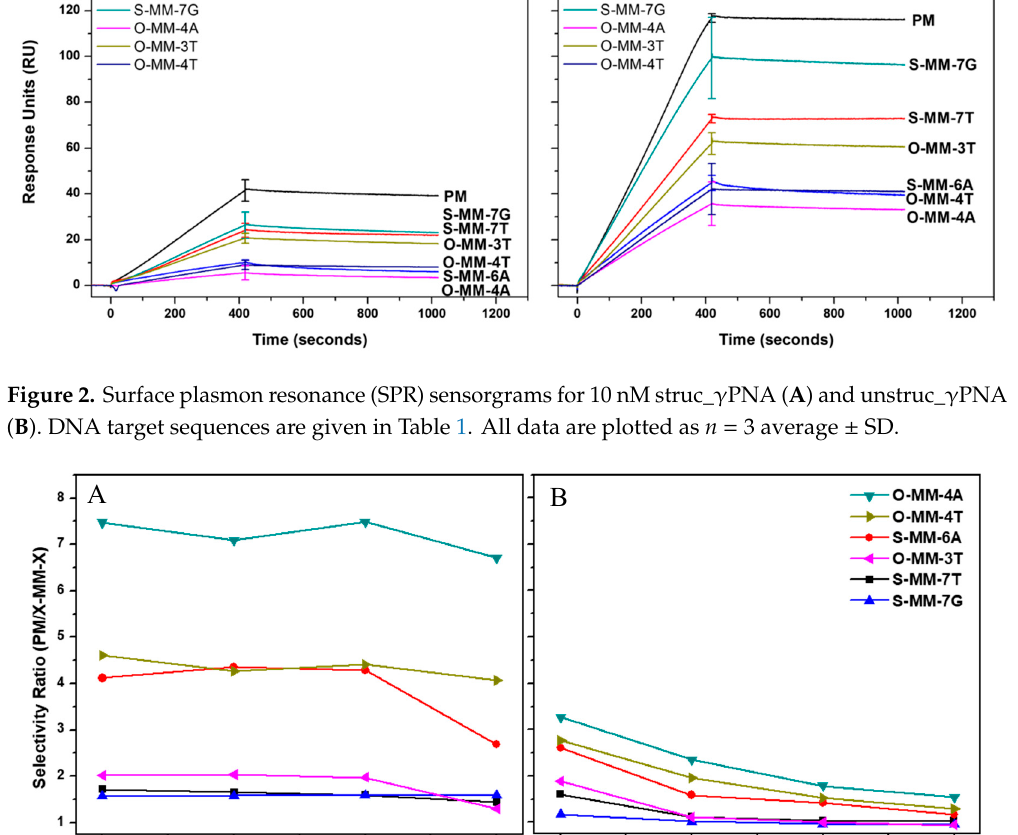
Figure 2. Surface plasmon resonance (SPR) sensorgrams for 10 nM struc_ γ PNA ( A ) and unstruc_ γ PNA ( B ). DNA target sequences are given in Table 1. All data are plotted as n = 3 average ± SD.